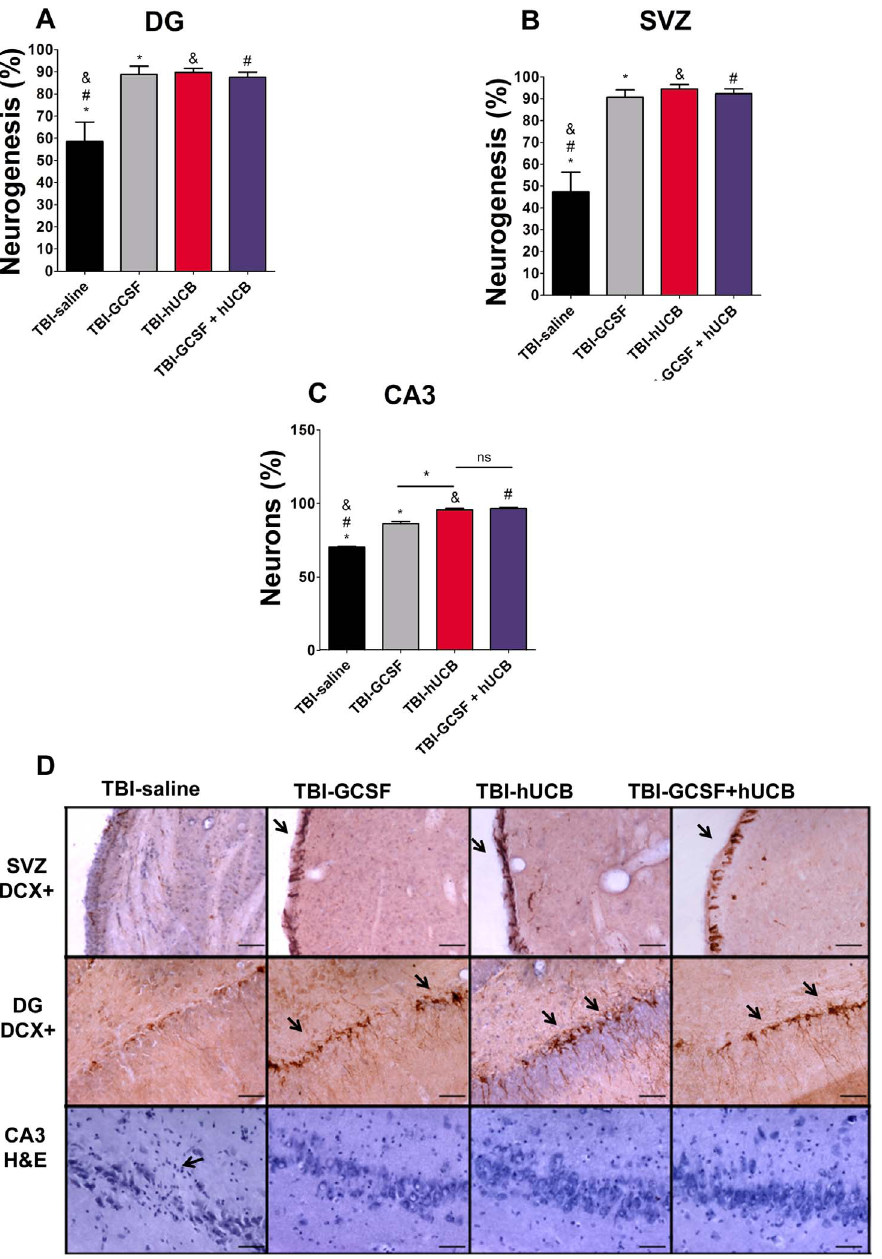
Figure 3. hUCB and G-CSF monotherapy, and combined hUCB + G-CSF attenuate TBI-induced impairment in endogenous neurogenesis and cell loss in rats exposed to chronic TBI. Significantly enhanced neural differentiation in the DG and SVZ and increased cell survival in CA3 after hUCB or G-CSF monotherapy, and the combined therapy of hUCB + G-CSF relative to saline alone. All 3 treatment conditions percent neurogenesis in the DG (Fig. 3A). Percent neurogenesis in the SVZ (Fig. 3B). Percentage of neuronal survival in the CA3 region of the hippocampus (Fig. 3C). Photomicrographs of SVZ, DG, and CA3 region (Fig. 3D) Top panel arrows indicate positive staining for neurogenesis in SVZ and DG respectivately. Arrow on bottom panel indicates CA3 pyramidal cell loss in TBI-saline (Fig. 3D). F 3,20 =159.3, p , 0.0001. Scale bars for Figure D=50 m m. *=significant difference between TBI-saline and TBI G-CSF; &=significant difference between TBI-saline and TBI-hUCB; # =significantly difference between TBI-saline and TBI-hADSC; ns=no significance. Significance at p’s , 0.05. doi:10.1371/journal.pone.0090953.g003 CSF cells, equally and significantly increased the estimated total number of new neurons in the both neurogenic sites of DG and SVZ relative to saline alone. The influence of hUCB cells or G-